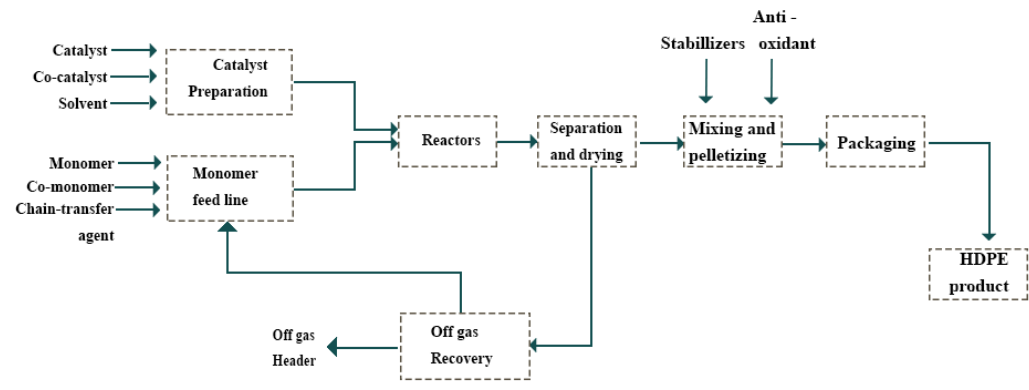
Figure 1. A diagram of slurry polymerization for HDPE production [20].